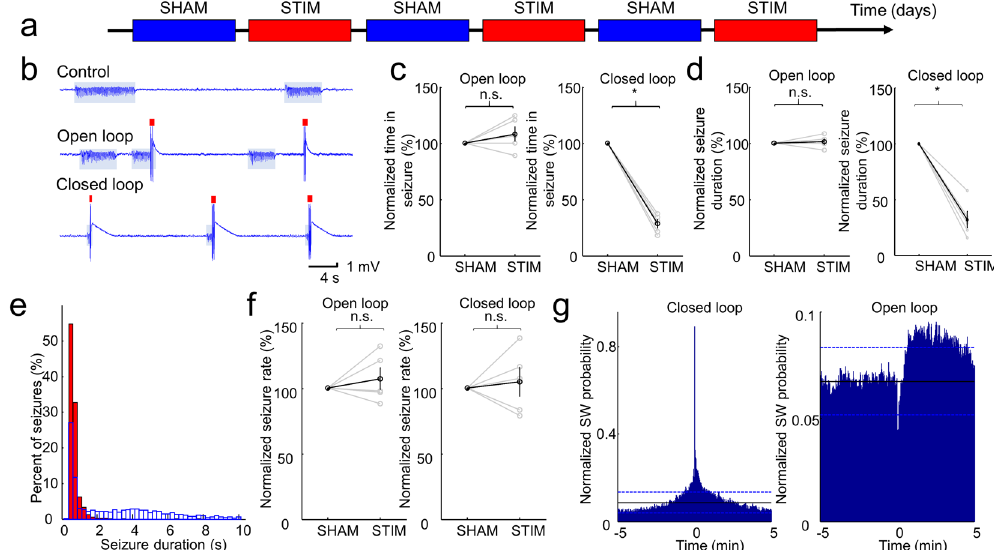
Figure 2. Results of the seizure suppression on the short term. ( a ) Experimental timeline showing a day-by-day alternation of sham and stimulated sessions. This pattern was repeated for 6 days. ( b ) Representative examples of LFP traces for the sham, pseudorandom and closed-loop seizure interruption protocols. Shaded bars and red ticks indicate the identified seizures and stimuli, respectively. (c) Time in seizure (normalized to the average seizure duration during the SHAM days for each animal) during SHAM and STIM days. Results from individual rats (grey lines) and group statistics (black lines) are shown. Stimulated day values are normalized to the preceding SHAM days’ values. Error bars represent ± SEM. ( d ) Average seizure duration (normalized to the average seizure duration during the SHAM days for each animal). Grey lines denote individual animals, while black lines represent the population data. Error bars represent SEM. ( e ) Representative example of the distribution of seizure durations during SHAM (blue) and STIM (red) days in one animal with closed- loop stimulation. ( f ) Seizure rates during the SHAM and STIM days (normalized to the average seizure rate during the SHAM days for each animal). Grey lines denote individual animals, while black lines represent the population data. Error bars represent SEM. ( g ) Peri-stimulus time histogram of the SW-complexes of a closed-loop and an open-loop stimulated rat across all the stimulated days. Black lines denote the average SW occurrence rate along the whole recording period and dashed blue lines refer to the confidence intervals (95%). Reference TES stimulus events are at time 0. * p < 0.01 , paired two-sample t-test ( c ), Wilcoxon rank sum test ( d ), paired two-sample t-test ( f